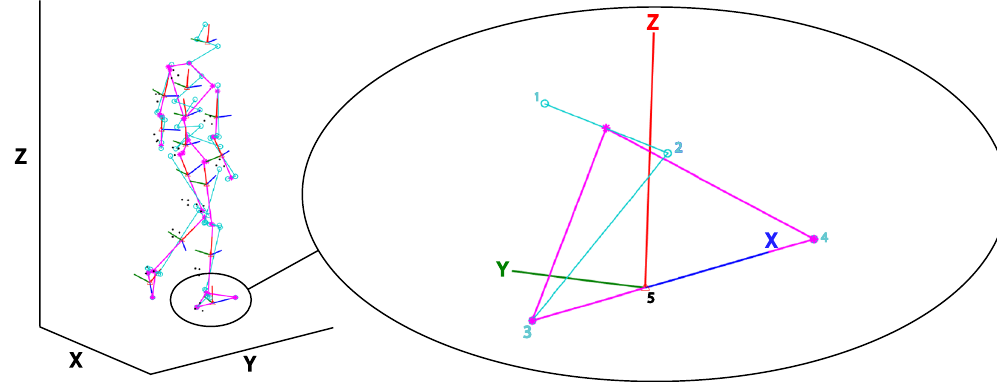
Figure 2. Local foot coordinate system. Based on digitized anatomical landmarks a model of this example participant was constructed. The full model has been depicted on the left. Magnified is the local coordinate system (X, Y, Z) of the right foot with its anatomical landmarks (light blue circles). The local coordinate system was constructed based on the medial (1) and lateral (2) malleoli, the calcaneus (3) and the second toe tip (4). The origin of the constructed coordinate system lies at the estimated foot’s CoM position (5). The red, dark blue and green lines represent respectively the local vertical (Z), forward (X) and mediolateral axes (Y). We defined our mediolateral CoP shift along the anatomical Y-axis in green. Note that in this figure this mediolateral axis points positively to medial, yet in our analysis we flipped the sign to define a lateral shift as positive and a medial shift as negative. This figure was created using Matlab 2021a (https:// www. mathw orks. com/ produ cts/ matlab. html) and Adobe Illustrator CC 2018 (https:// www. adobe. com/ nl/ produ cts/ illus trator.